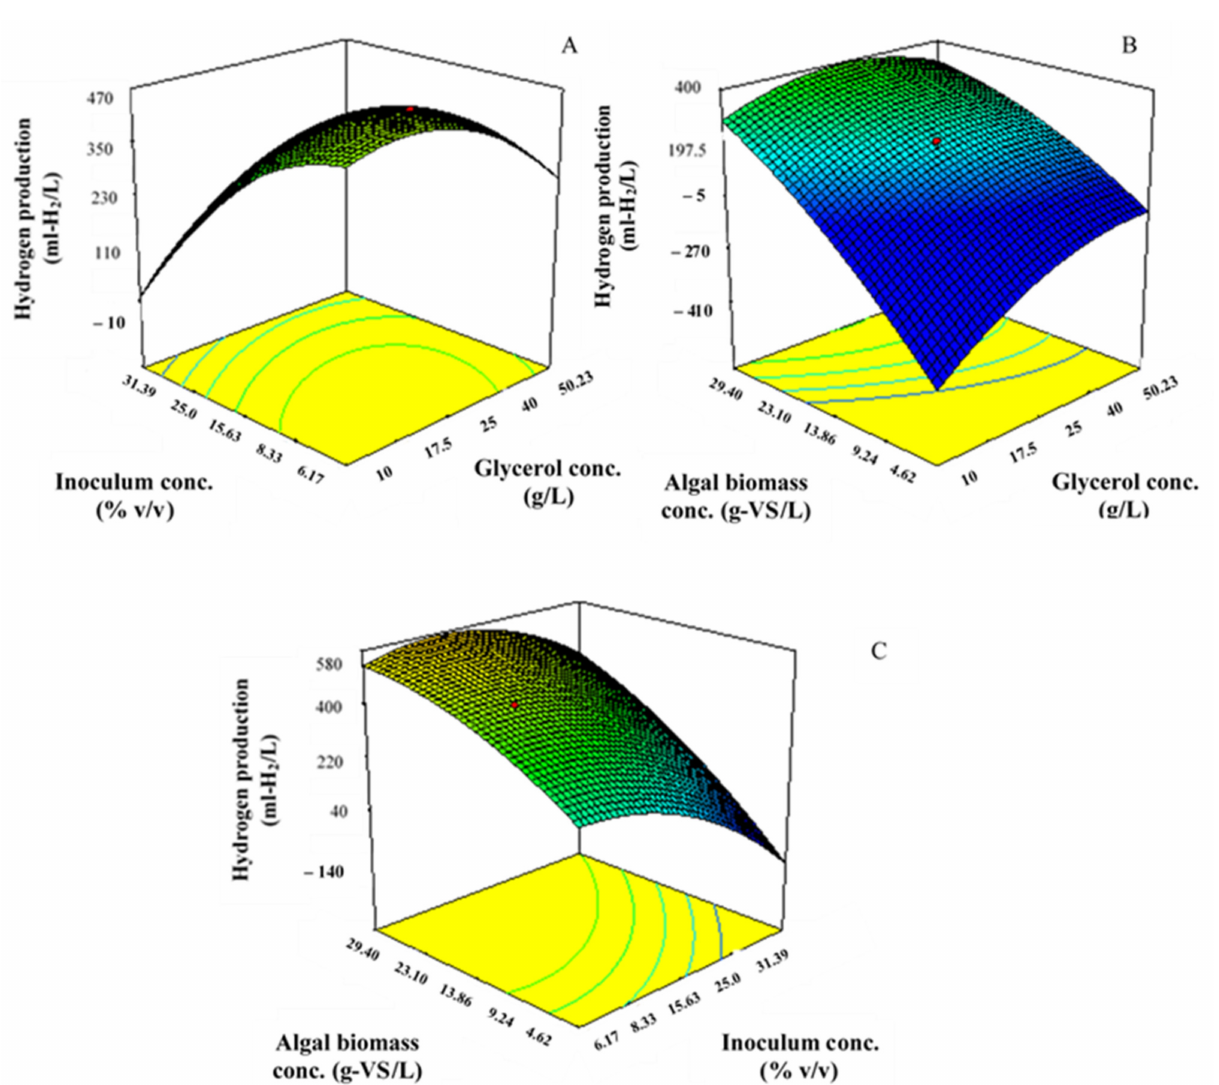
Figure 1. Surface plots showing the effects of crude glycerol and inoculum on hydrogen production and their interactive effects at 13.86 g-VS/L of algal biomass ( A ); the effect of algal biomass, crude glycerol, and interactive effect at 15.63% ( v / v ) of inoculum concentration ( B ); the effect of algal biomass, inoculum, and interactive effect at crude glycerol of 25 g/L ( C